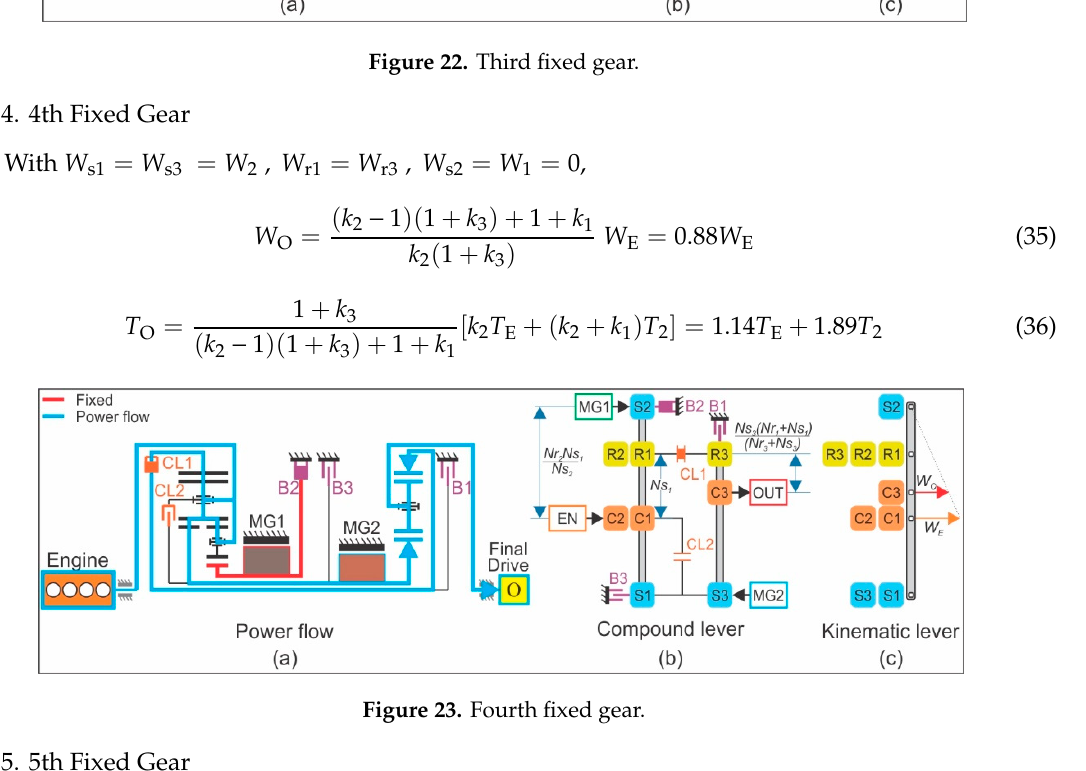
Figure 23. Fourth fixed gear.